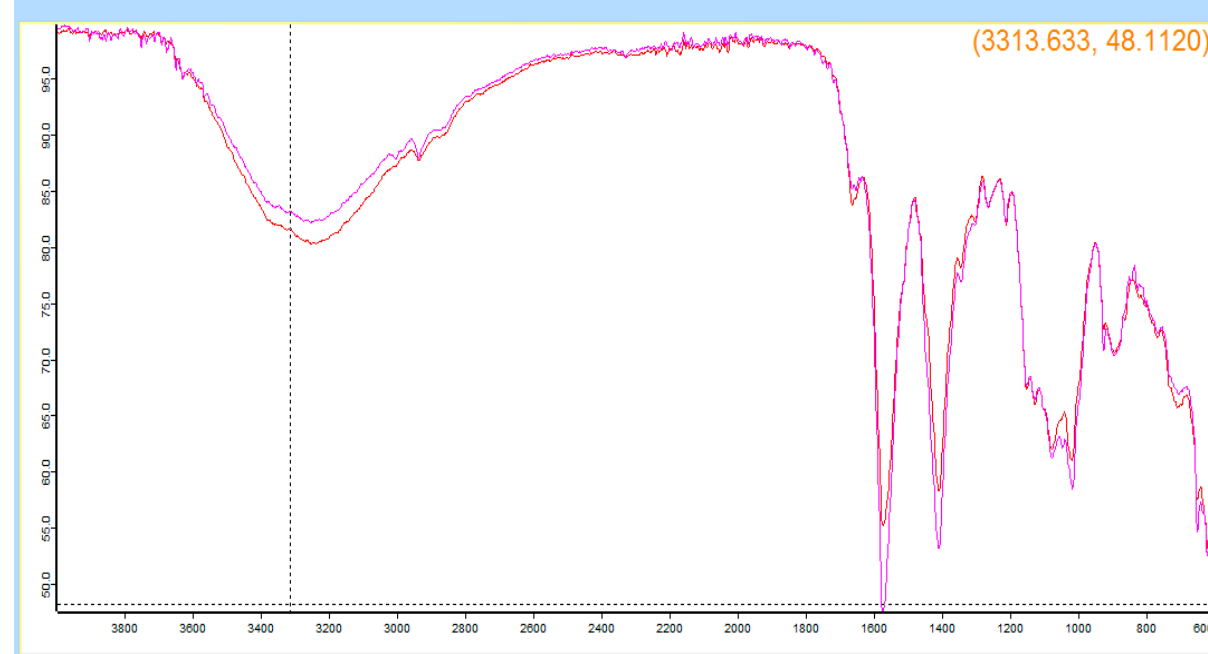
10 of 15 Figure 4. Desirability chart for biovanillin production using Punica granatum peels through sol- id-state fermentation. 3.4. Identification and Quantitative Assessment of Biovanillin Characterization of extracted biovanillin via solid-state fermentation using Punica granatum peels was done by Fourier transform infrared (FTIR) spectroscopy against standard vanillin. The FTIR spectrum of the precipitated product obtained from crystal-